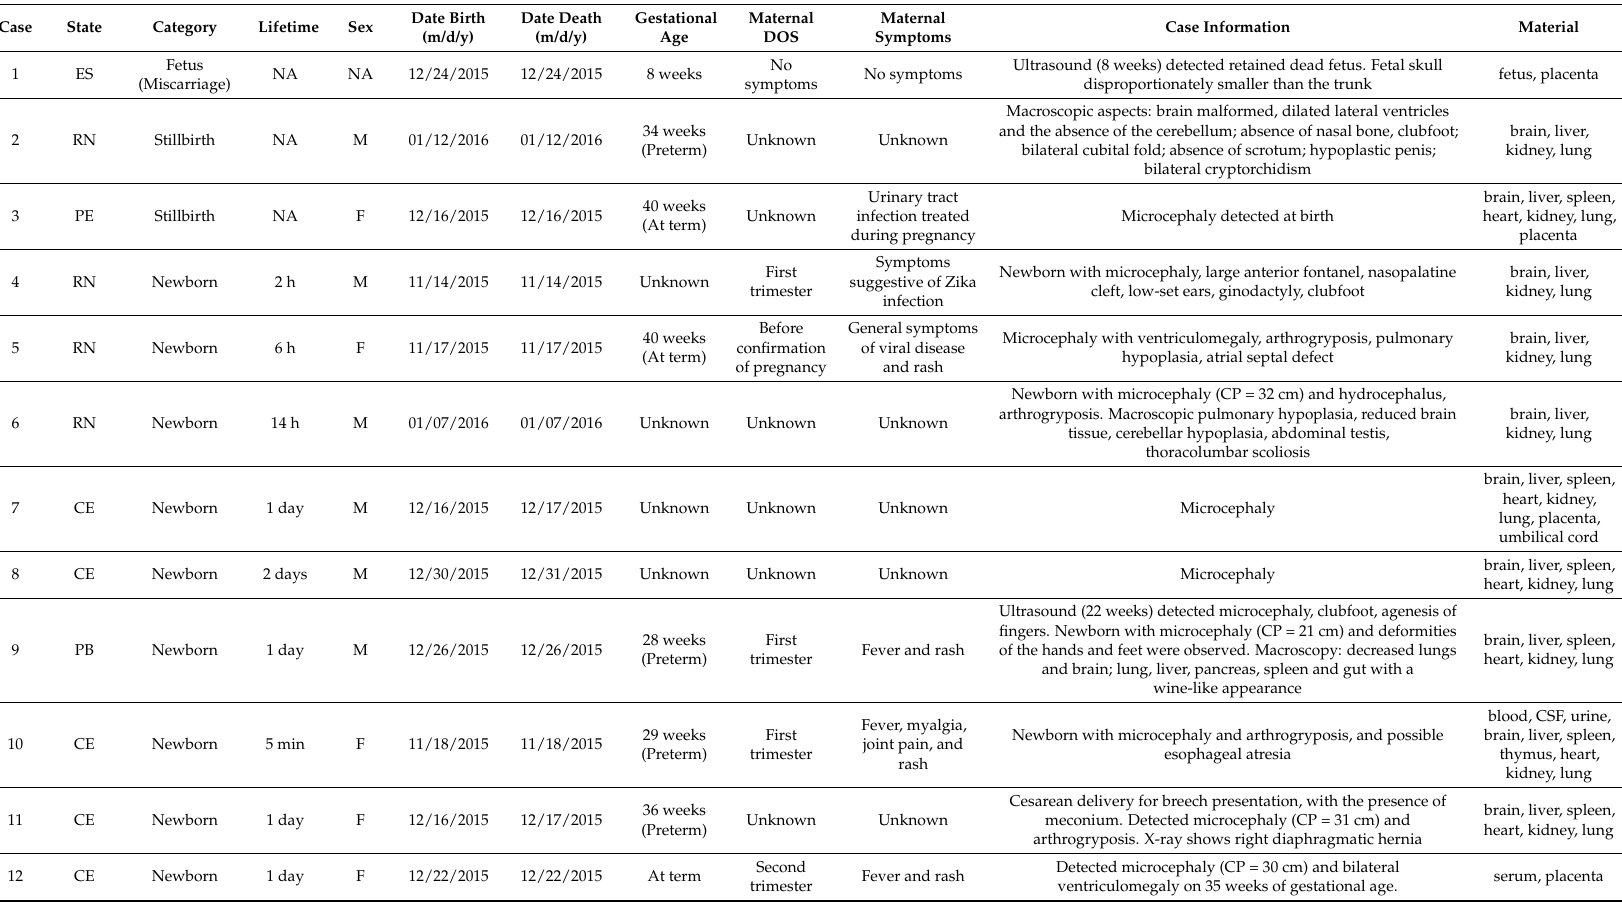
Table 1. Information about the 12 fatal cases of Zika virus (ZIKV)